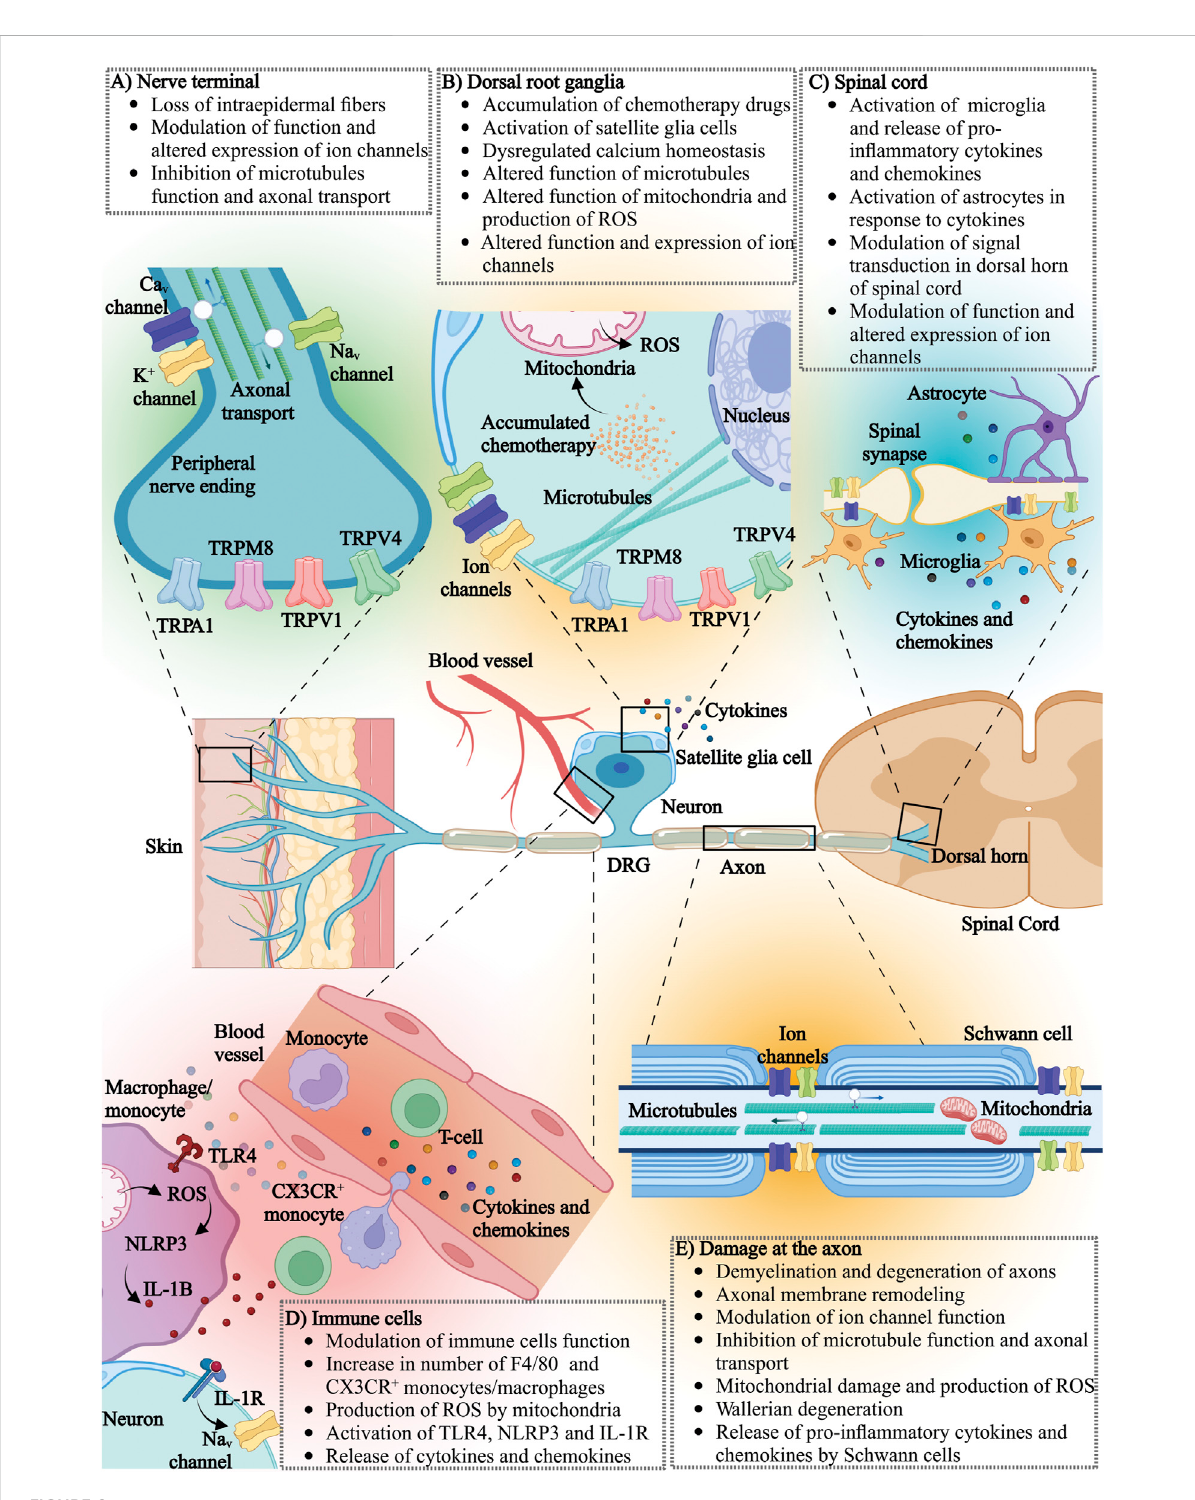
FIGURE 2 The effects of chemotherapy on various components of the nervous and immune system: (A) nerve terminal, (B) dorsal root ganglia (DRG), (C) spinal cord, (D) immune cells and (E) neuronal axons. Ca V , voltage-gated calcium channel; K + , potassium channel; Na V , voltage-gated sodium channel; TRPA1, transient receptor potential (TRP) ankyrin 1; TRPM8, transient receptor potential cation channel subfamily melastatin member 8; TRPV1, transient receptor potential vanilloid-type 1; TRPV4, transient receptor potential vanilloid-type 4; ROS, reactive oxygen species; TLR4, toll-like receptor 4; NLRP3, NOD-, LRR- and pyrin domain-containing protein 3; IL-1B, interleukin-1 beta; IL-1R, interleukin-1 receptor; CX3CR, CX3C chemokine receptor